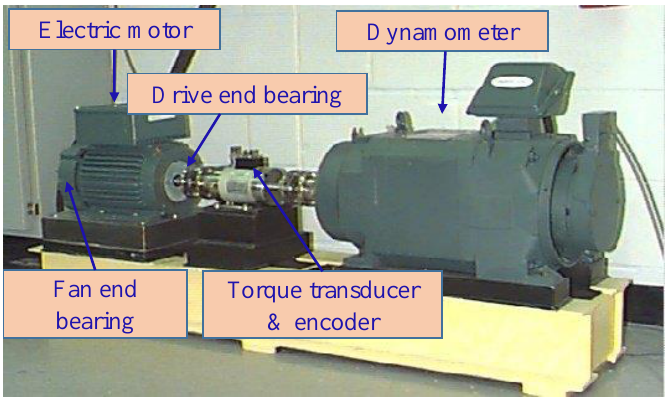
Figure 4. CWRU bearing test rig.